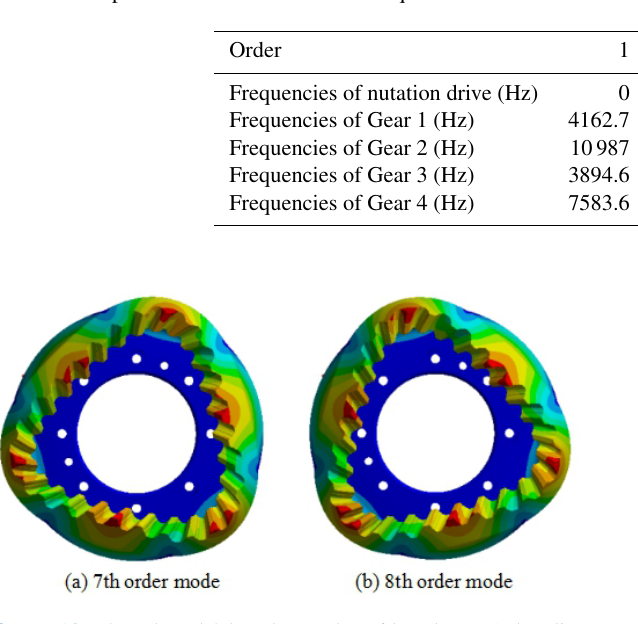
Figure 13. The 9th and 10th order modes of bevel gear 1: radial